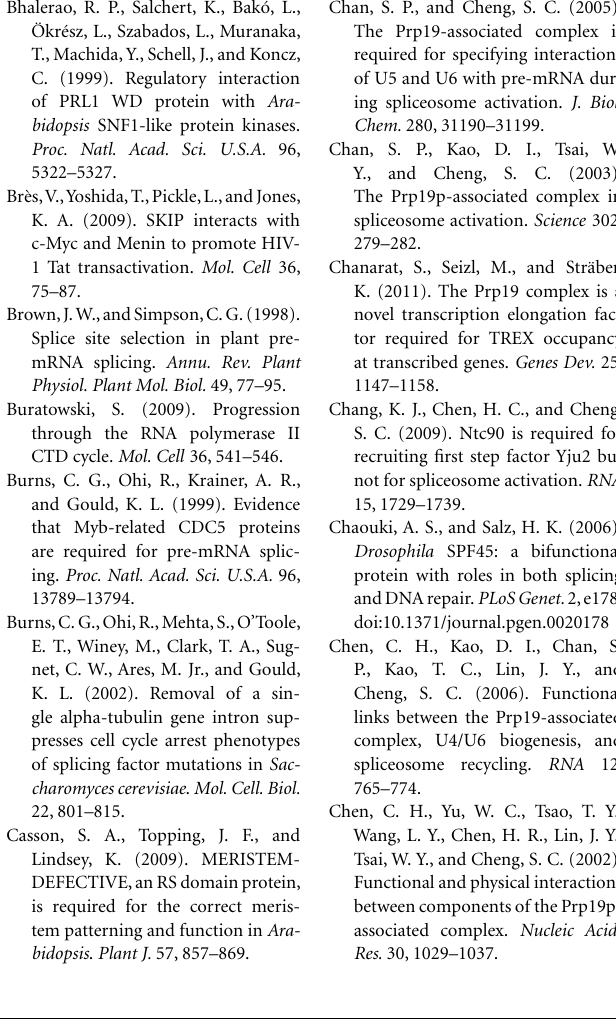
functions are indicated in bold. Core subunits of yeast, human, and Arabidopsis NTC complexes are shaded in gray. References describing the purification of various spliceosomal and NTC complexes are given at the end of theTable corresponding to numbers in bracket indicated in the heading. Brackets within the table mark unique fission yeast factors, which have either Drosophila or human or Arabidopsis homologs. For each factor, the corresponding NCBI gene accession number is depicted and in all cases frequently used alternative designations are